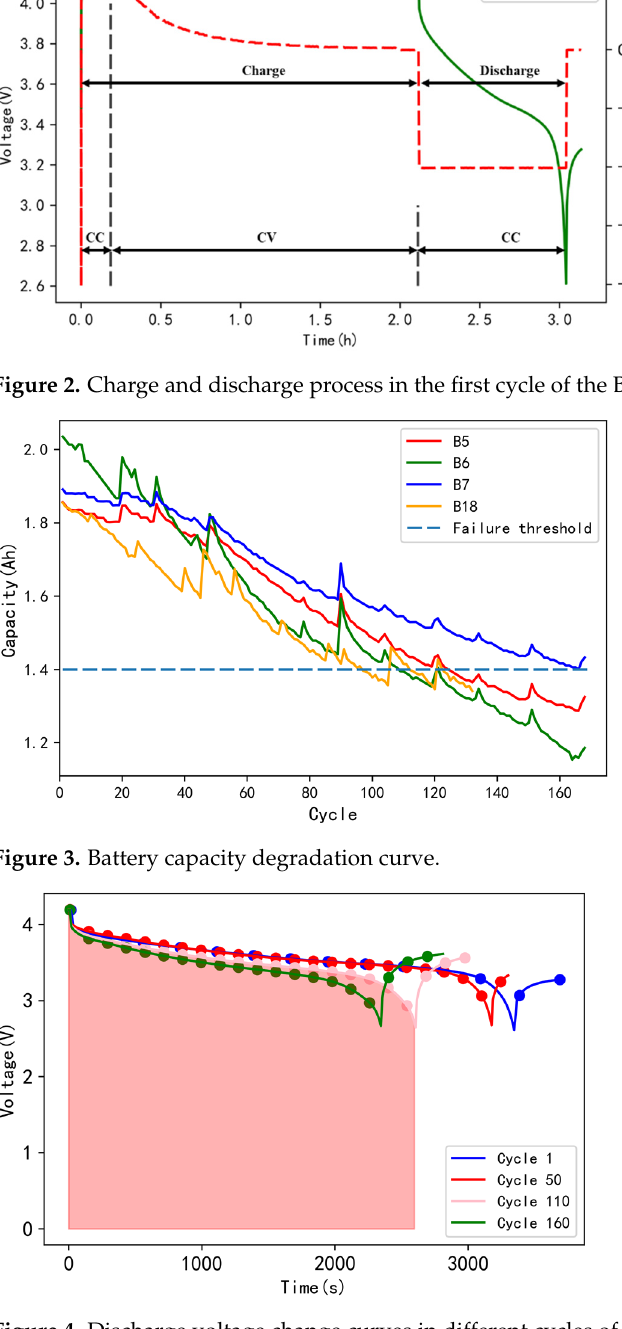
Figure 5. Change curves of the IVTs. 3.3. Pearson’s Correlation Analysis Pearson’s correlation analysis is commonly used to measure the degree of correlation between two sets of variables. Assuming that the two sets of variables are {